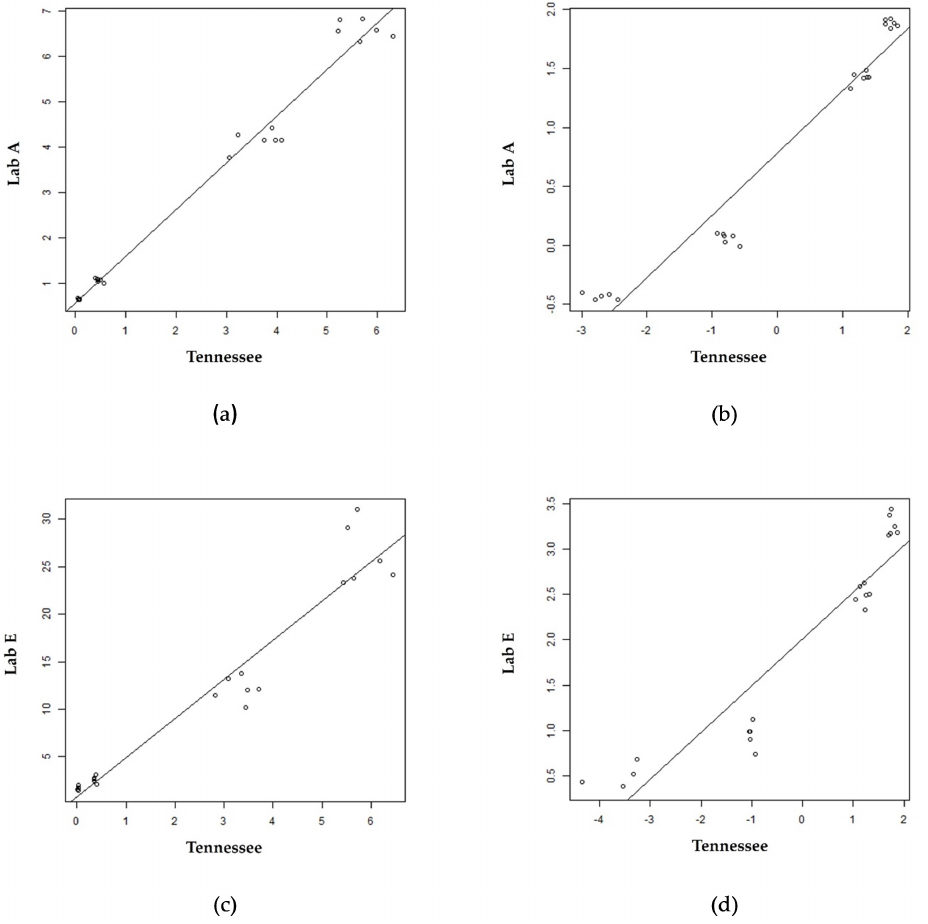
Figure 2. Scatter plot overlayed with linear regression line of raw enzyme and log enzyme values for the QC pools (A, B, C, and D pools moving up the line) for two labs using Tennessee as a reference lab: ( a ) GAA raw; ( b ) GAA log; ( c ) IDUA raw; ( d ) IDUA